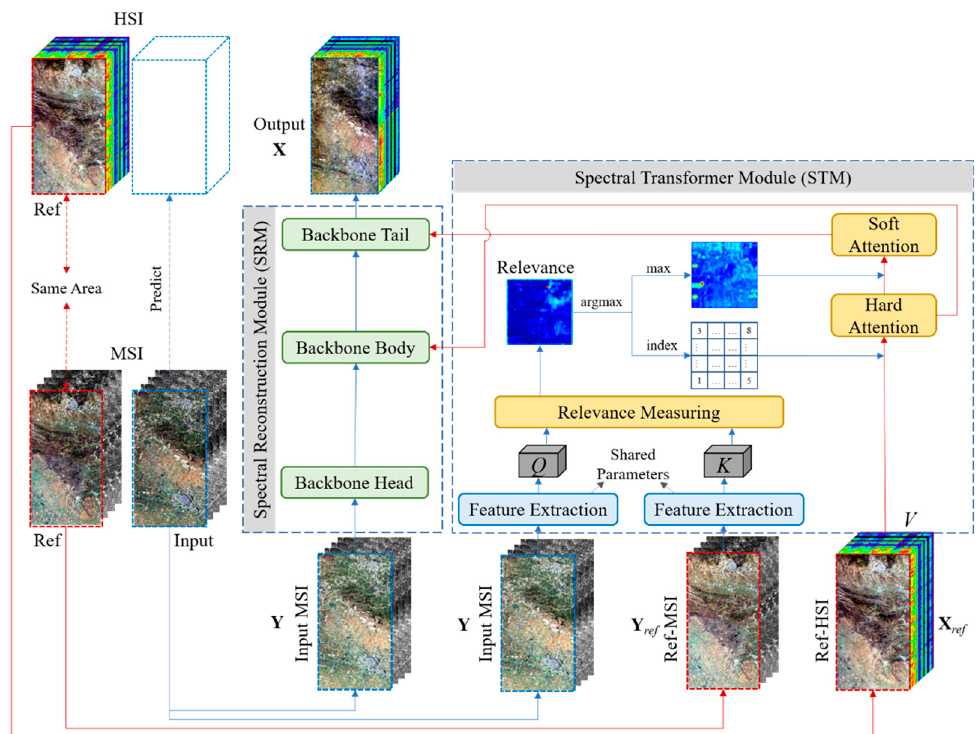
Figure 1. Network architecture of the proposed LSTNet. The input MSI is the image to be processed. The ref-MSI and ref-HSI are a paired MSI and HSI, used as reference images. Q and K are the features extracted from the input MSI and ref-MSI, denoting query and key, where the used feature extraction sub-networks are shared parameters. V denotes the spectral values transformed from the ref-HSI. Relevance denotes the spatial attention relevance between the input MSI and ref-MSI.